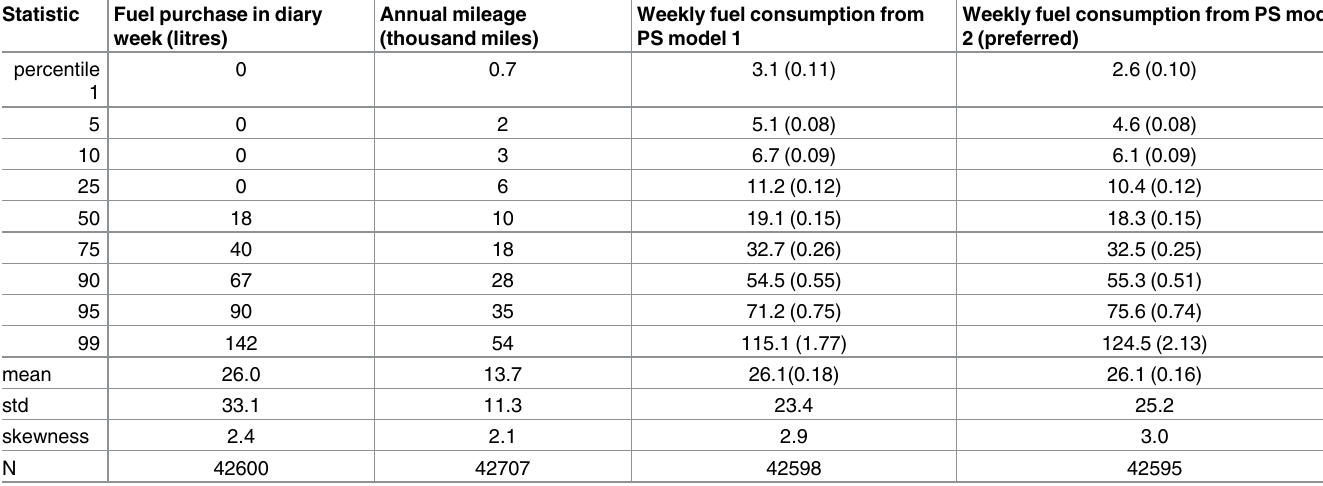
Table 2. Estimatesfrom PSM based imputation, recorded fuel purchase and mileage. Statistic Fuel purchase in diary week